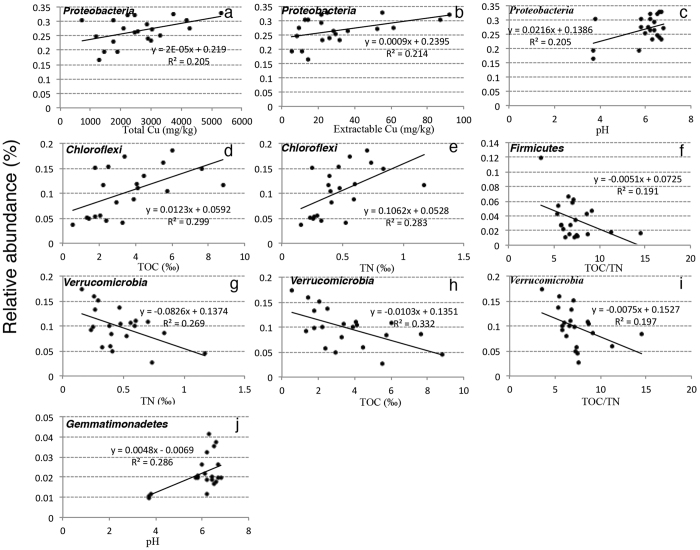
Relationship between five major lineages phyla abundance and environmental factors (p < 0.05): (a) Proteobacteria against total Cu, (b) Proteobacteria against extractable Cu, (c) Proteobacteria against pH, (d) Chloroflexi against TOC, (e) Chloroflexi against TN, (f) Firmicutes against TOC/TN, (g) Verrucomicrobia against TN, (h) Verrucomicrobia against TOC, (i) Verrucomicrobia against TOC/TN, and (j) Gemmatimonadetes against pH.